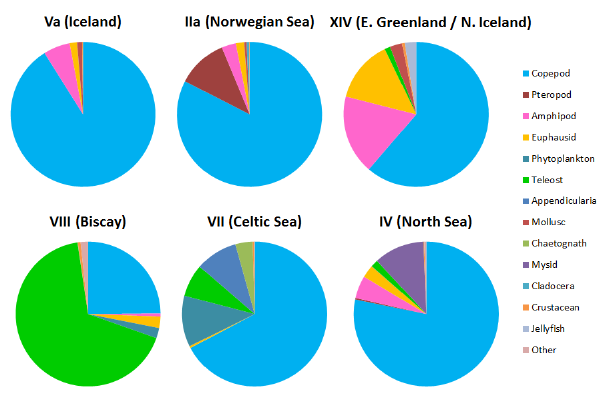
Figure 5. Diet composition of herring Clupea harengus in differ- ent parts of the northeast Atlantic (ICES Divisions). Proportions are based on the number of individual prey